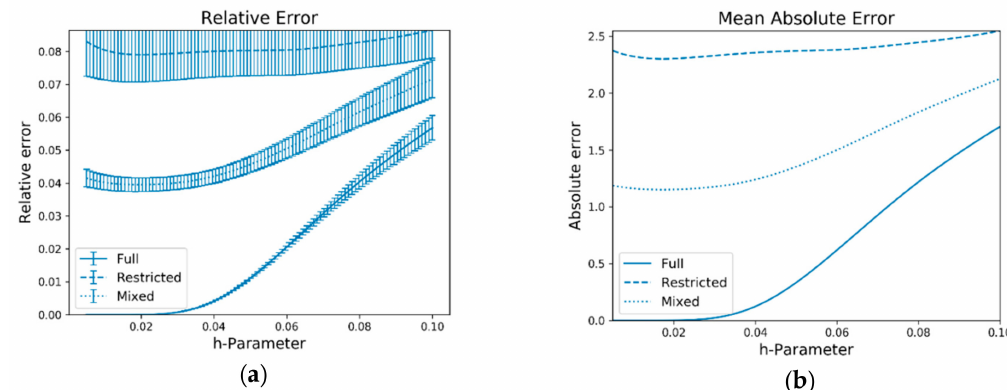
Figure 10. Results of the Heating load 2_floors problem for the full, restricted and mixed models with the parameter selection h = ω . ( a ) MAPE depending on h ; ( b ) MAE depending on h . A selection of h = 0.02 gives as results the models shown in Figure